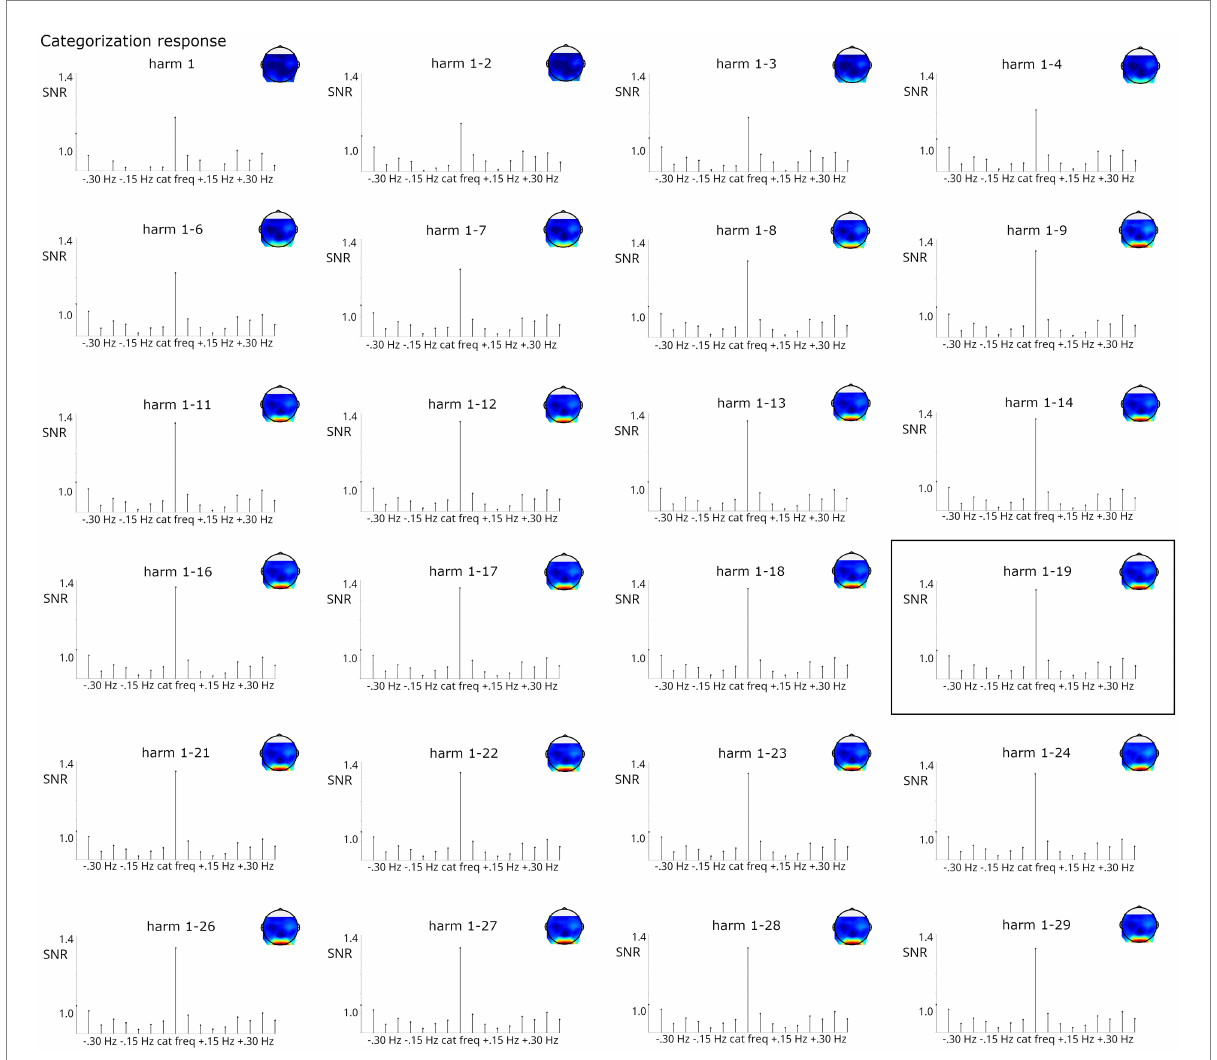
FIGURE 9 SNR of categorization grand-average responses summed across increasing numbers of harmonics (considering only the 1 st or up to harmonics 1–29, always excluding harmonics corresponding to the frequency). Highly significant responses were obtained in all analyses. The analysis on harmonics 1–19, marked by a black box, was indicated by the Z-score